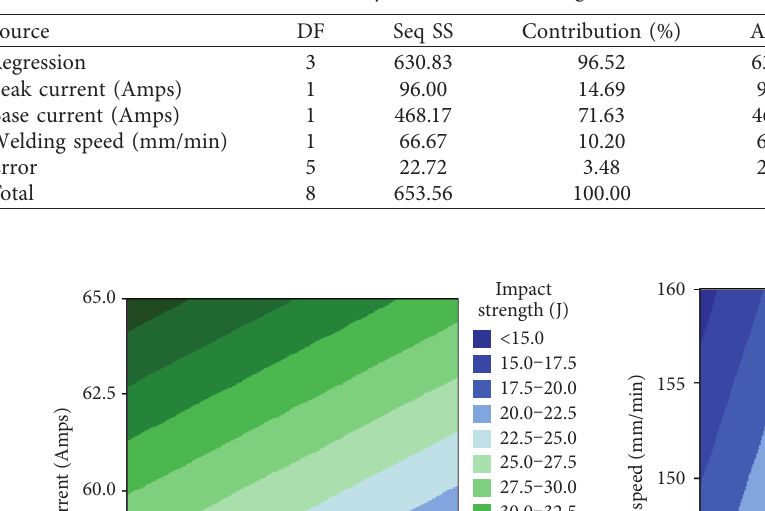
Figure 11: Residual plots for impact test. Table 13: Analysis of variance for regression model (S/N ratio-impact